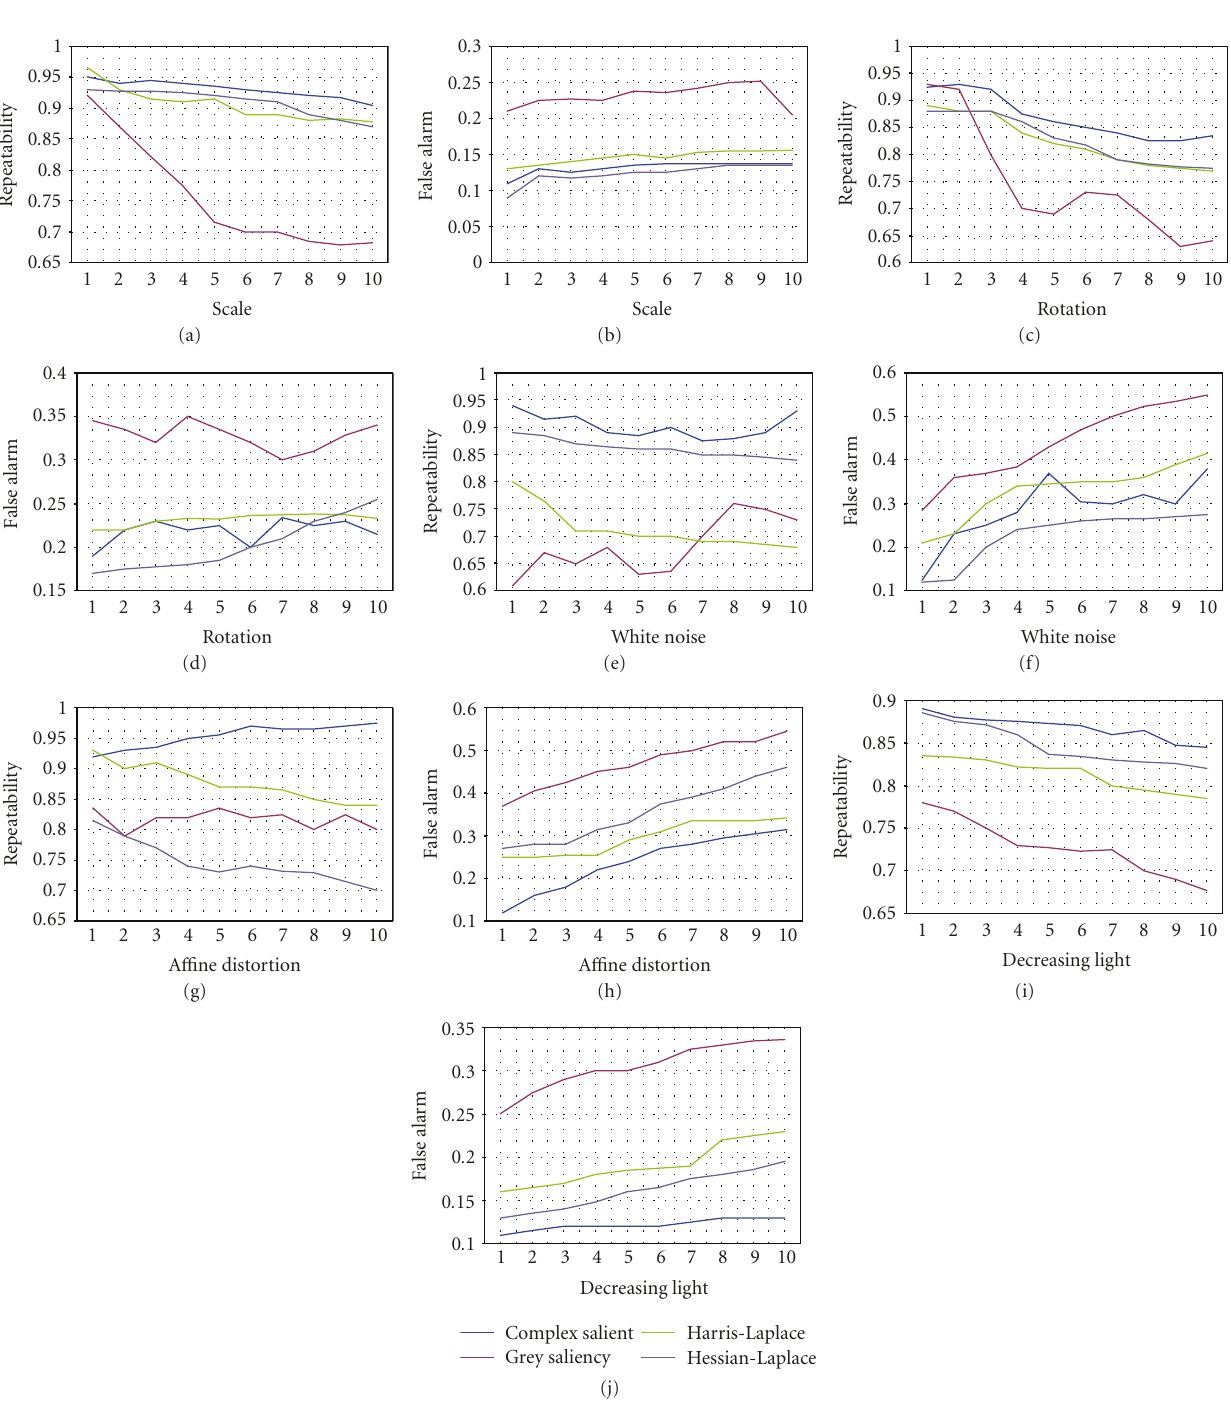
Figure 11: Repeatability and false alarm rate in the space of transformations: (a), (b) scale, (c), (d) rotation, (e), (f) white noise, (g), (h) a ffi ne invariants, and (i), (j) decreasing